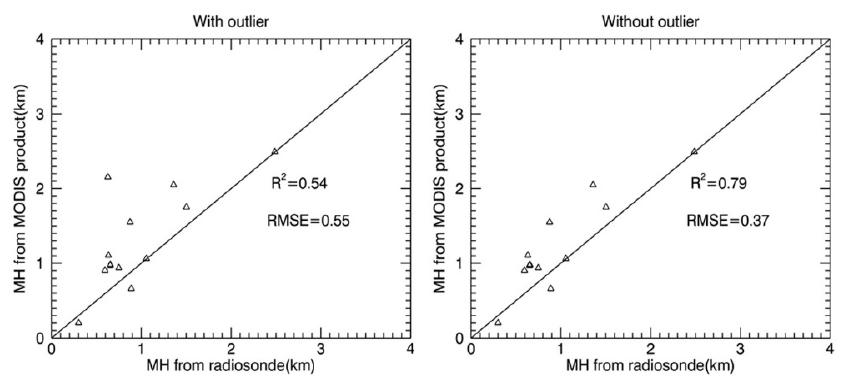
Figure 9. R 2 and RMSE for the MH values retrieved using our method and radiosonde data for all days (a) and for convective days (b) at the Heihe river basin in 2008 and 2012.